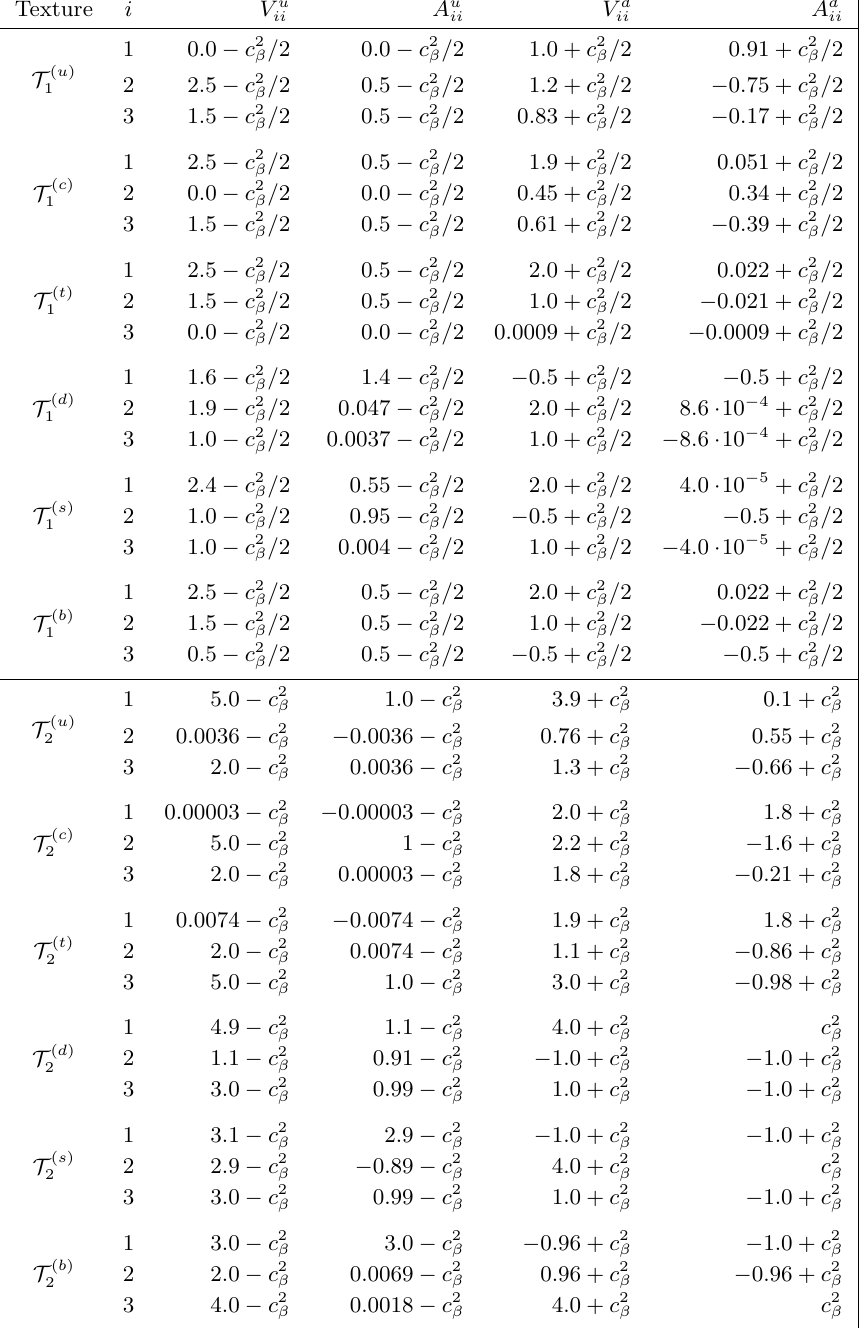
Table 3 . Diagonal vector ( V q